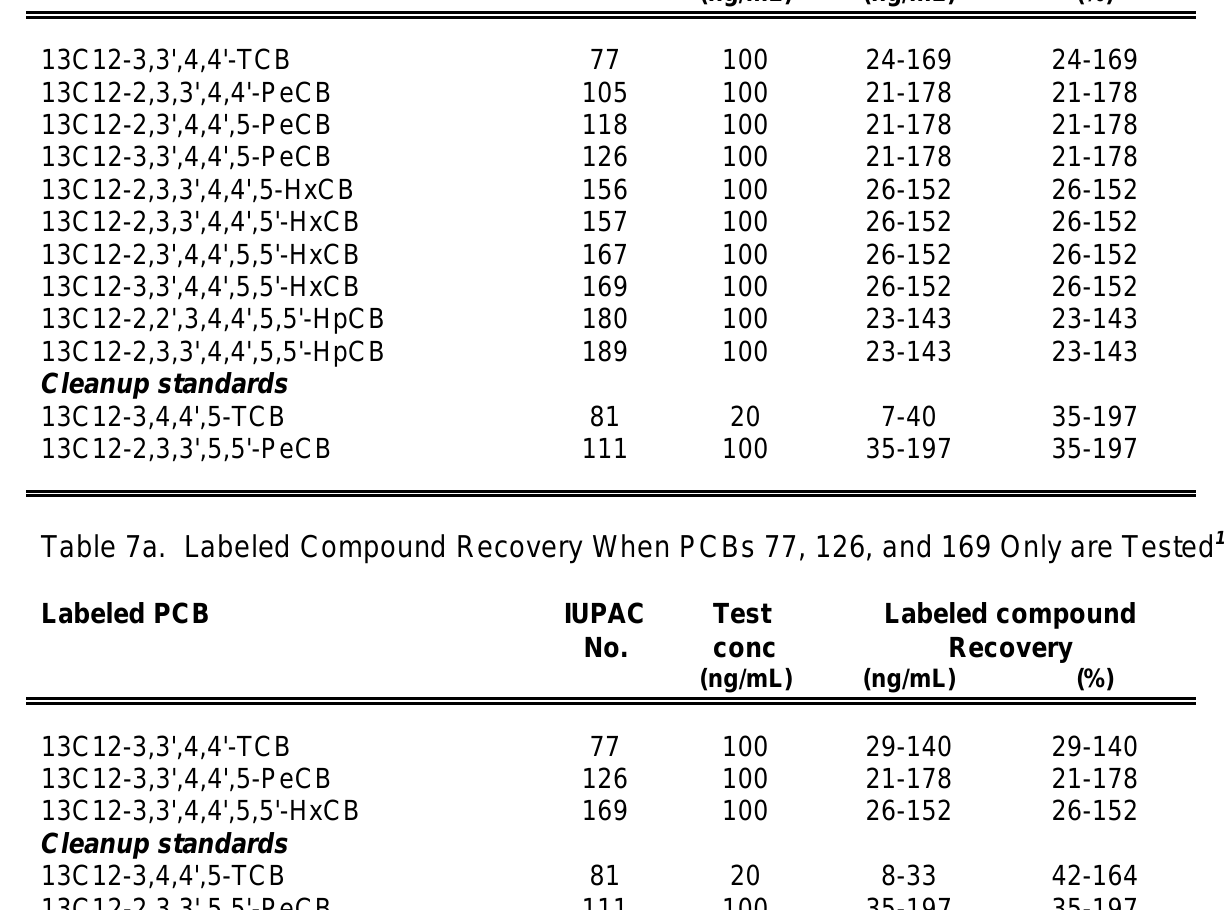
Cleanup standards